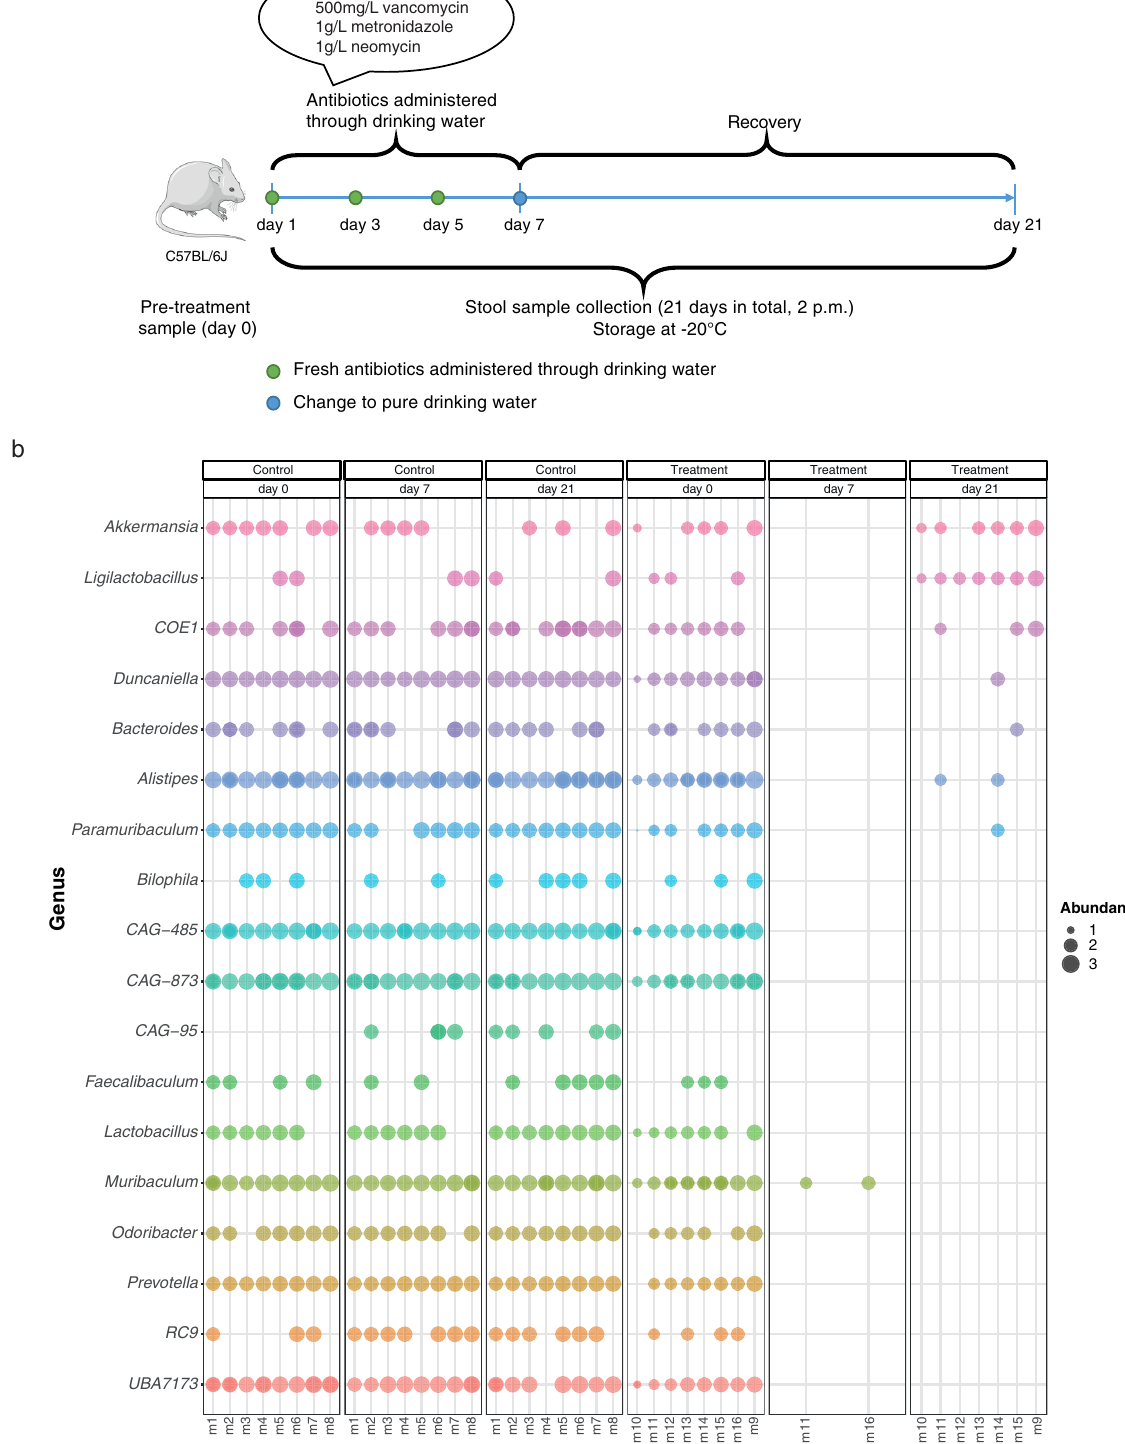
Fig. 1 Experimental design and metagenome-assembled genome pro fi les. a Representative illustration demonstrating the project overview, including dates and collections of treatment, and fecal sample collection. Eight single-housed mice per group were treated with an antibiotic cocktail (treatment) or water (control), longitudinally. Fecal samples collected at days 0, 7, and 21 were used for microbiome and antimicrobial resistance pro fi ling. b Genus level representation of the MAGs recovered from control and treatment groups – pre and post (day 0, day 7, and day 21 respectively) antibiotic administration. Source data are provided as a Source Data fi